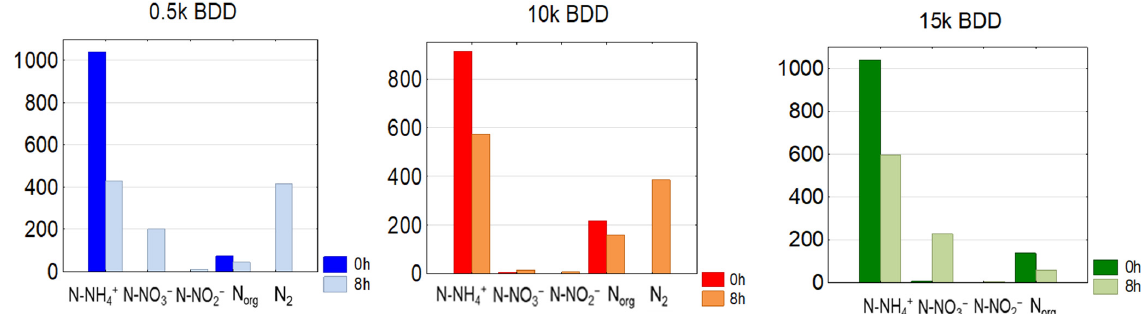
Figure 7. Average C 0 and C 8h concentrations of nitrogen compounds in treated LLs by means of different anodes used, j = 100 mA·cm − 2 (N org = TN − (N-NH 4+ + N-NO 3 − + NO 2 − )).